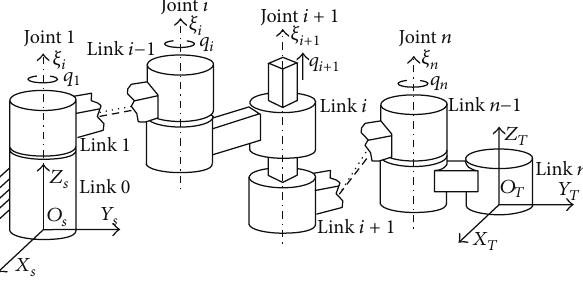
Figure 2: Forward kinematics of an 𝑛 -DOF